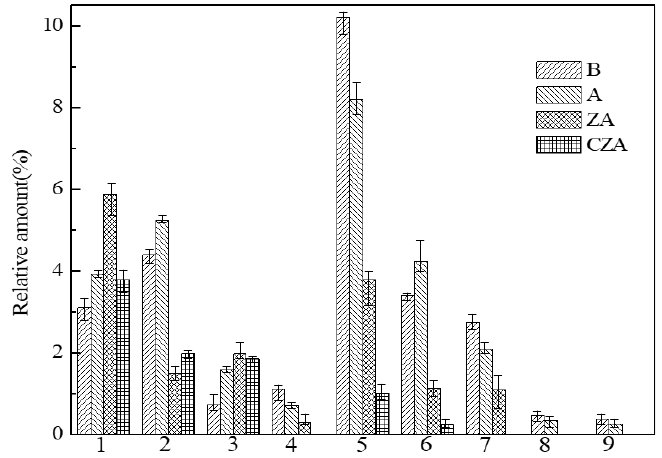
Figure 6. Phenol compounds distribution as a function of catalysts. 1. Phenol, 2. Xylenol, 3. Ethyl phenol, 4. Benzenetriol, 5. Syringol, 6. Metoxyphenol, 7. Vinyl-methoxy phenol, 8. Methyl methoxyphenol, 9. Ethyl